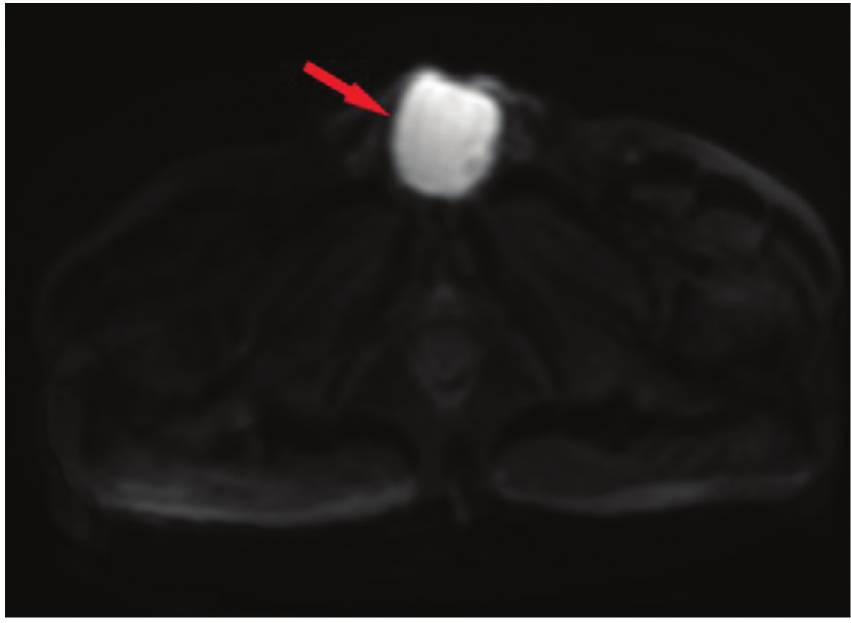
Figure 5. DWI scan showing a round-like cystic mass with high signal intensity in the cavernous body of the penis root.